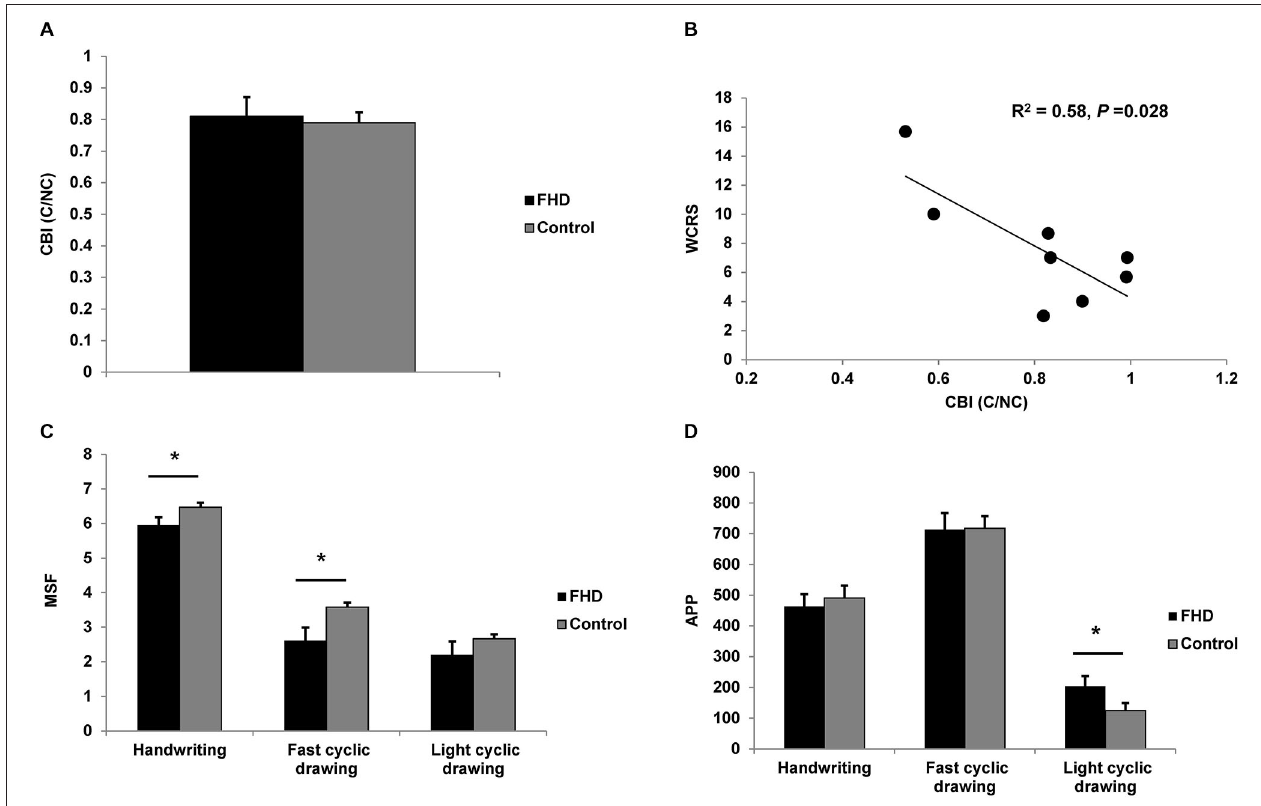
slower than the control group for handwriting and fast cyclic drawing. A similar pattern was observed for light cyclic drawing. (D) Average pen pressure (APP) for the three tasks. There was a difference between groups only for light cyclic drawing. Significance at P < 0.05 is signified by